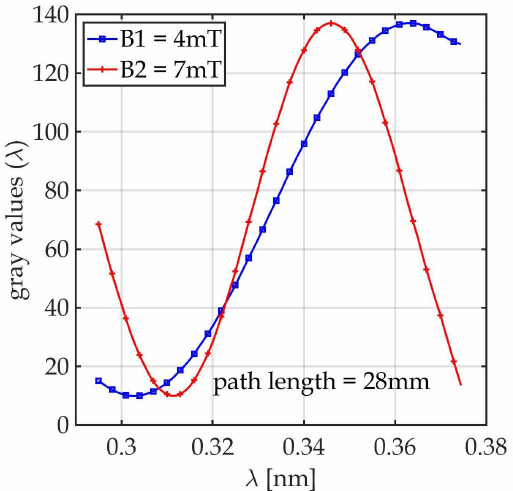
Figure 5. Two magnetic fields (4 mT and 7 mT) show nearly the same gray value for λ = 0.32 nm and a path length = 28 mm, a small change of λ = 0.34 nm increases the difference from 5 to 32 gray values, i.e., if the B-field in a sample is unknown, changing the wavelength may help identify B. A longitudinal magnetic transfer function can be achieved by measuring the image fringe contrast as a function of different B with decreasing path length s. A fringe pattern is obtained by a proper coil operated with different currents, and measured by polarized neutron imaging (see Figure 6). The longitudinal spatial B resolution refers to the path length in the direction of the neutron trajectory through B. A fraction of this path length correlates with a fraction of the spin-flip and results in a different gray value in the image than a full spin-flip.